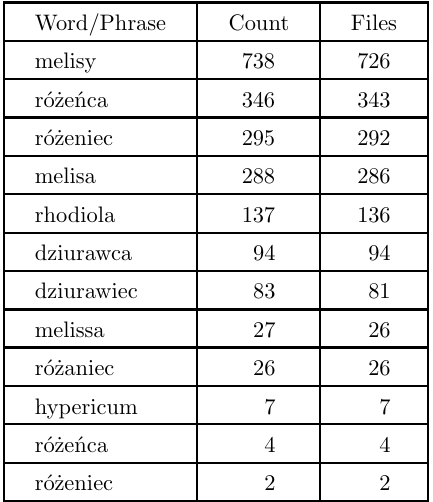
Table 1. Frequency of occurrence of inclusion words